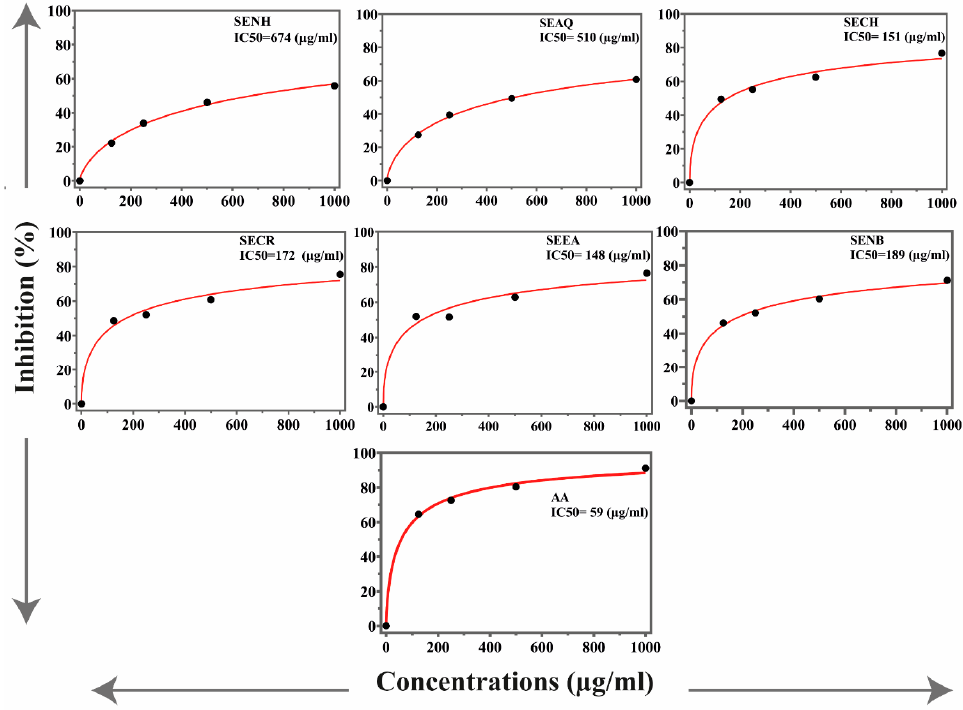
Figure 1. The antioxidant activities of S. edelbergii extracts. SE, S. edelbergii; NH, n-hexane; AQ, aqueous; CH, chloroform; NB, n-BuOH; EA, EtOAc; CR, crude; AA, ascorbic acid. Data were taken as mean ± SEM and n = 3 with p ≤ 0.01 **.